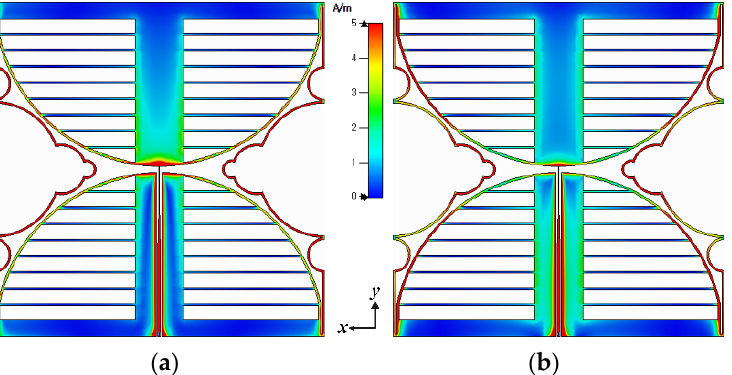
Figure 9. Surface current distributions of the proposed antenna at ( a ) 470 MHz, ( b ) 700